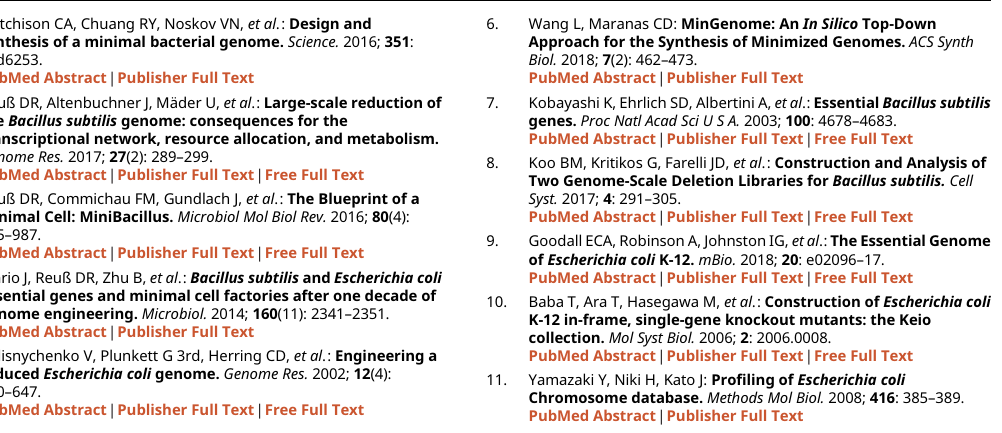
Table 2. Pan-genome graph statistics for B. subtilis and E. coli. (cid:129) Table 3. The number of deleted genes from B. subtilis reduced strains which are noncore versus core. (cid:129) Table 4. Large noncore regions which have not been deleted from any of the strains delta 6, IIG-Bs27-47-24, or PG10, PS38.